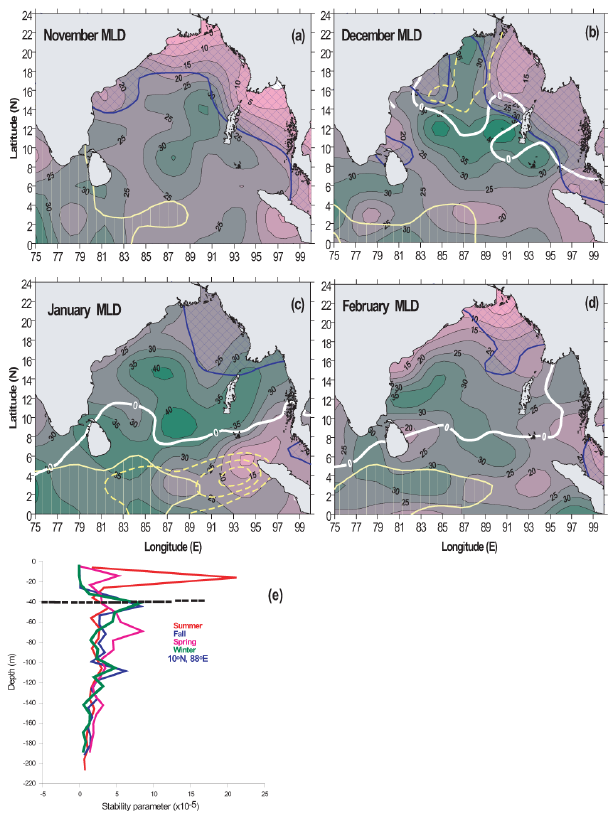
Figure 8. Monthly mean climatology of mixed layer depth (m) in the Bay of Bengal during winter in (a) November, (b) December, (c) January, and (d) February and (e) vertical profiles of the up- per ocean stability parameter ( E , m − 1 ) at 10 ◦ N, 88 ◦ E. In (a–d) the blue crosshatch represents the region where salinity is less than 32psu, while vertical lines within the thin yellow solid line rep- resent the region where the salinity is greater than 34.5psu. The thick broad white line indicates the zero wind stress curl and the region south of it (equatorward) have positive wind stress curl. The yellow broken contours indicate the positive wind stress curl (5– 20 × 10 − 8 Pam − 1 ) with increasing magnitude towards the